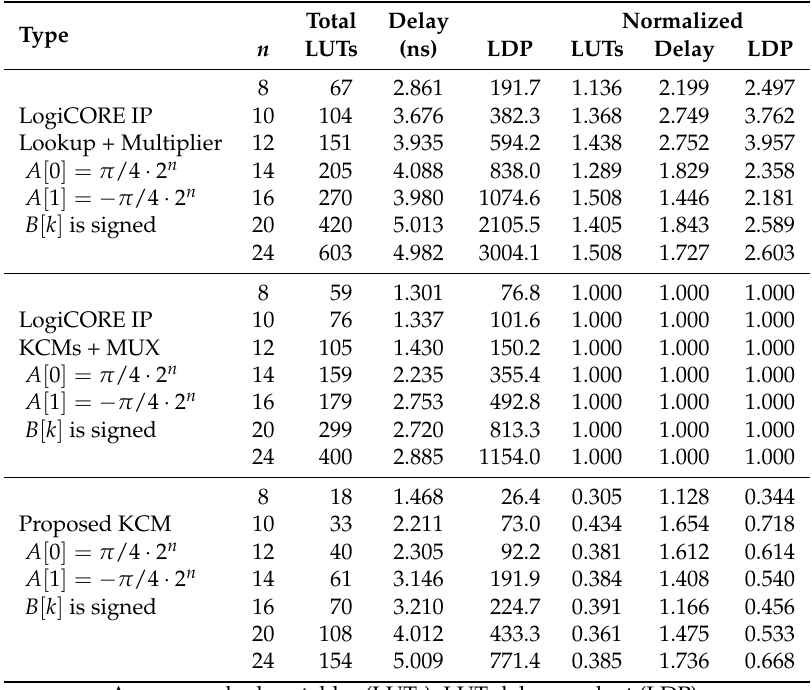
Table 7. Synthesis results for single-cycle ( m × n )-bit KCMs with two selectable coefficients, where m = n , A [ k ] = ± π /4 · 2 n and both B [ k ] are signed variables. Proposed units use 62% fewer LUTs on average compared to LogiCORE IP KCM-based